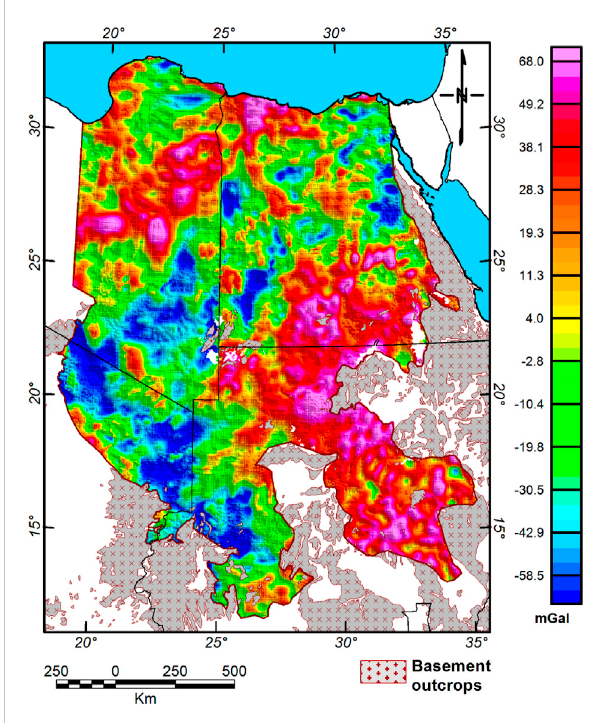
FIGURE 9 Gravity map on the surface of the basement after removing the gravity effect of sedimentary cover.